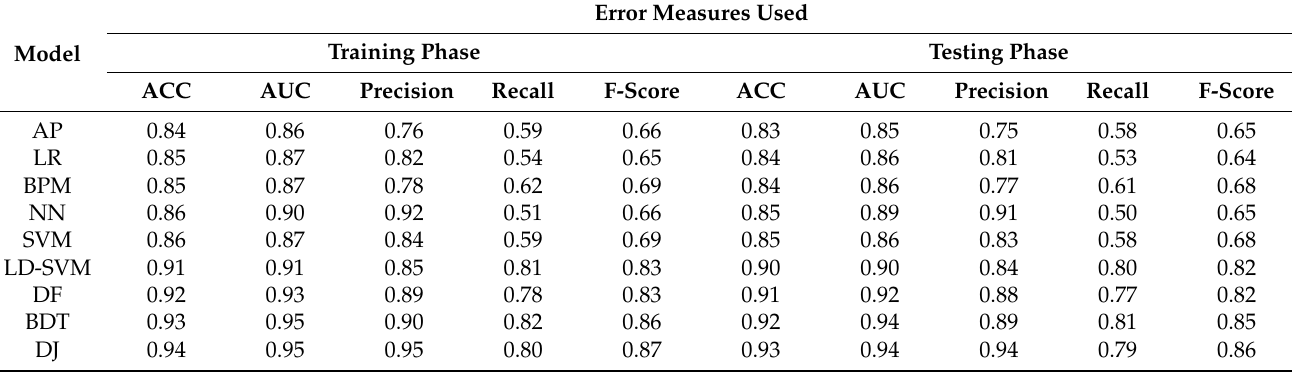
Table 3. Examining the performance of the models used using error